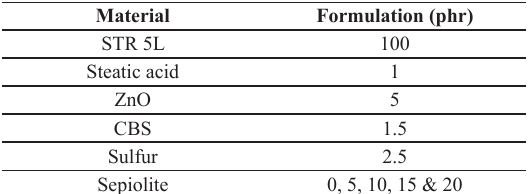
Table 1. The formulation used for compounding the sepiolite filled NR composites.